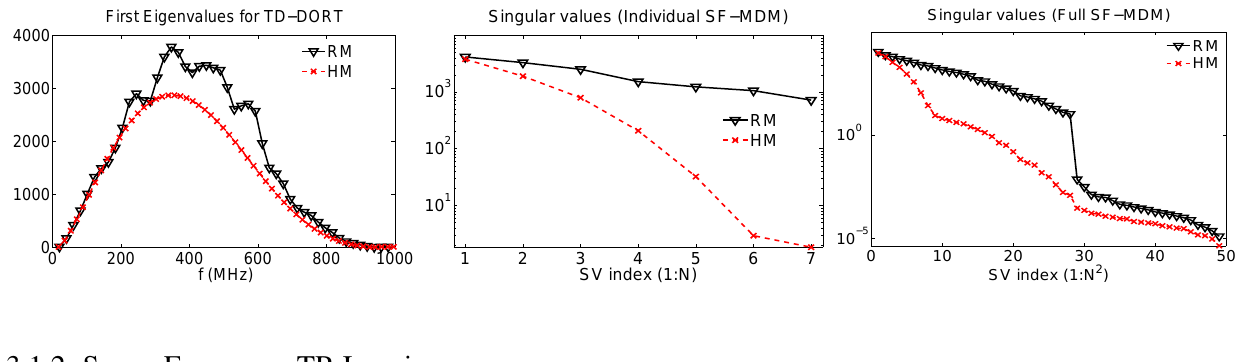
Figure 6. The first eigenvalue distribution (most and only significant one in this case) of the space-space MDM with respect to the frequency (left) and singular values of the individual (center) and full (right) space-frequency